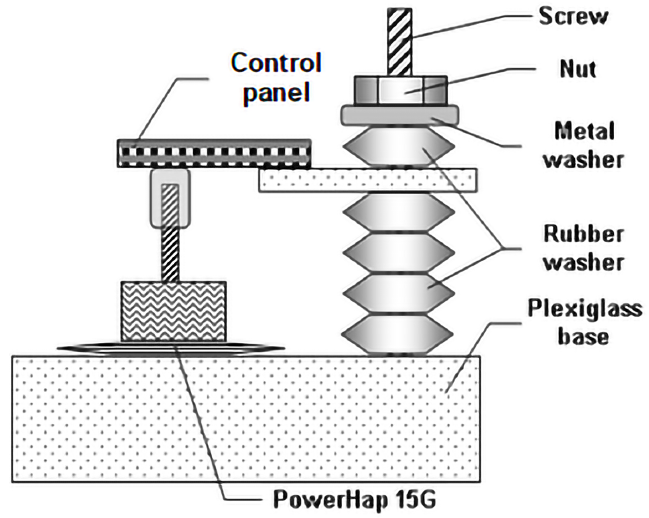
Figure 5. PowerHap 15G actuators placement underneath the control